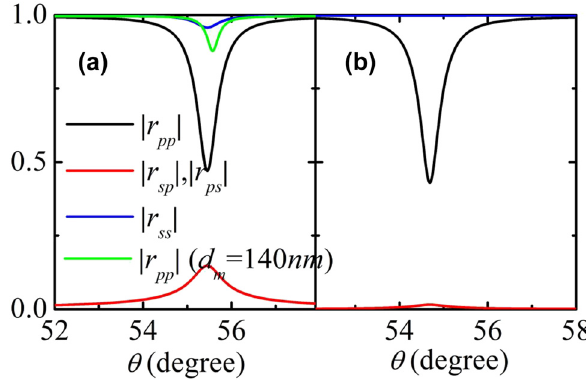
Figure 5: The reflections of the structure with chirality (a) 𝜅 = 0.5 and (b) 𝜅 = 0.05. Here, d